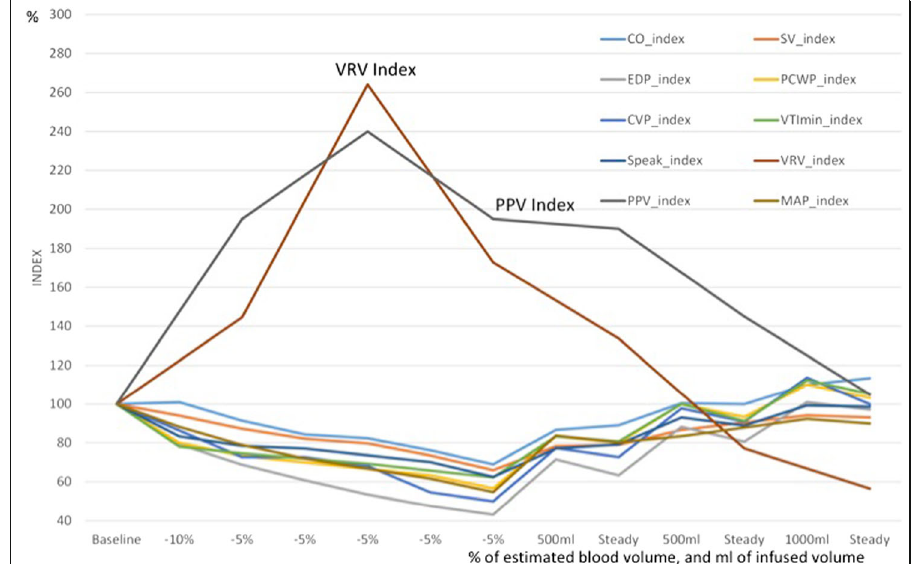
Fig. 7 Shows changes in the VRV index, VTI min in SVC, and static markers for hypovolemia. Values are normalized to 100 points at the baseline. This means that all variables started at 100%, and the graphs show their changes during the different stages of the experiment. VRV venous return variation index, PPV pulse pressure variations, CO cardiac output, EDP end-diastolic pressure, CVP central venous pressure, S integral, MAP mean arterial